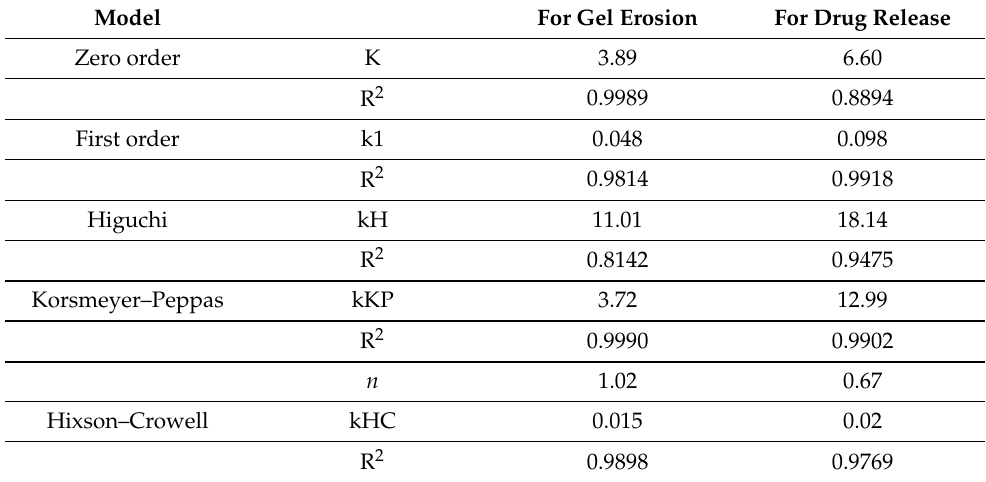
Table 3. Kinetic modelling of erosion profile and in vitro drug release.